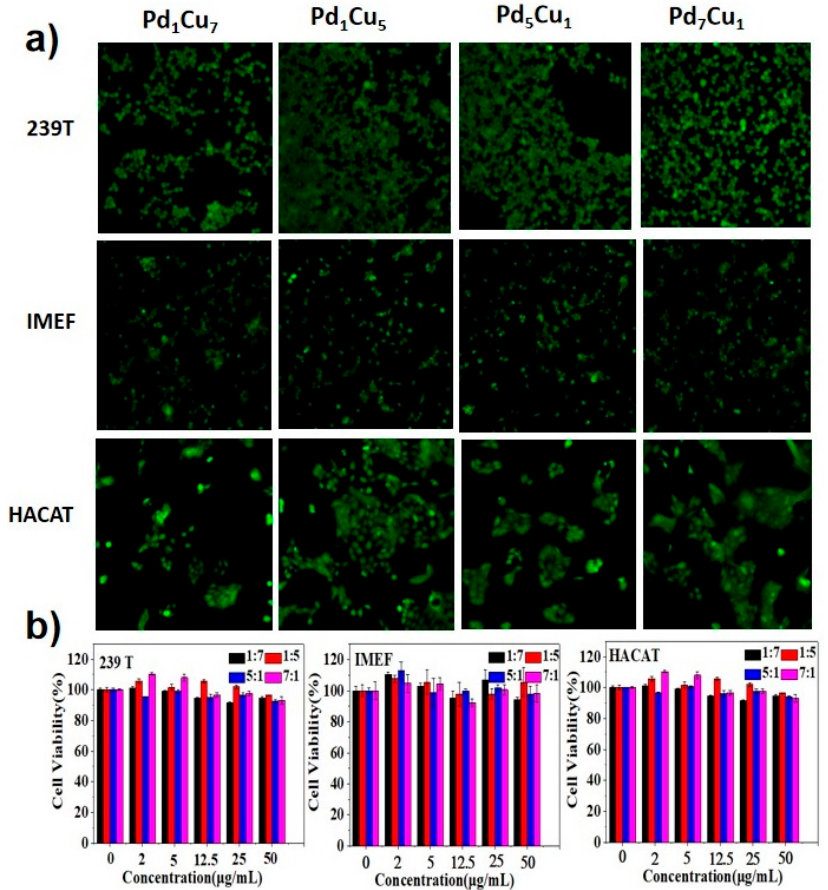
Figure 2. ( a ) Representative fluorescence microscopy images of 239 T cell, IMEF cell, HACAT cell, which were treated by using 50 µ g mL − 1 colloidal solutions (Pd 1 Cu 5 , Pd 1 Cu 7 , Pd 5 Cu 1 , Pd 7 Cu 1 alloy NPs). ( b ) Relative cell viability of different cell lines (239 T cell; IMEF cell; HACAT cell) exposed to four different concentrations (blank, 2 µ g mL − 1 , 5 µ g mL − 1 , 12.5 µ g mL − 1 , 25 µ g mL − 1 , 50 µ g mL − 1 ) NPs (Pd 1 Cu 5 , Pd 1 Cu 7 , Pd 5 Cu 1 , Pd 7 Cu 1 ) for 2